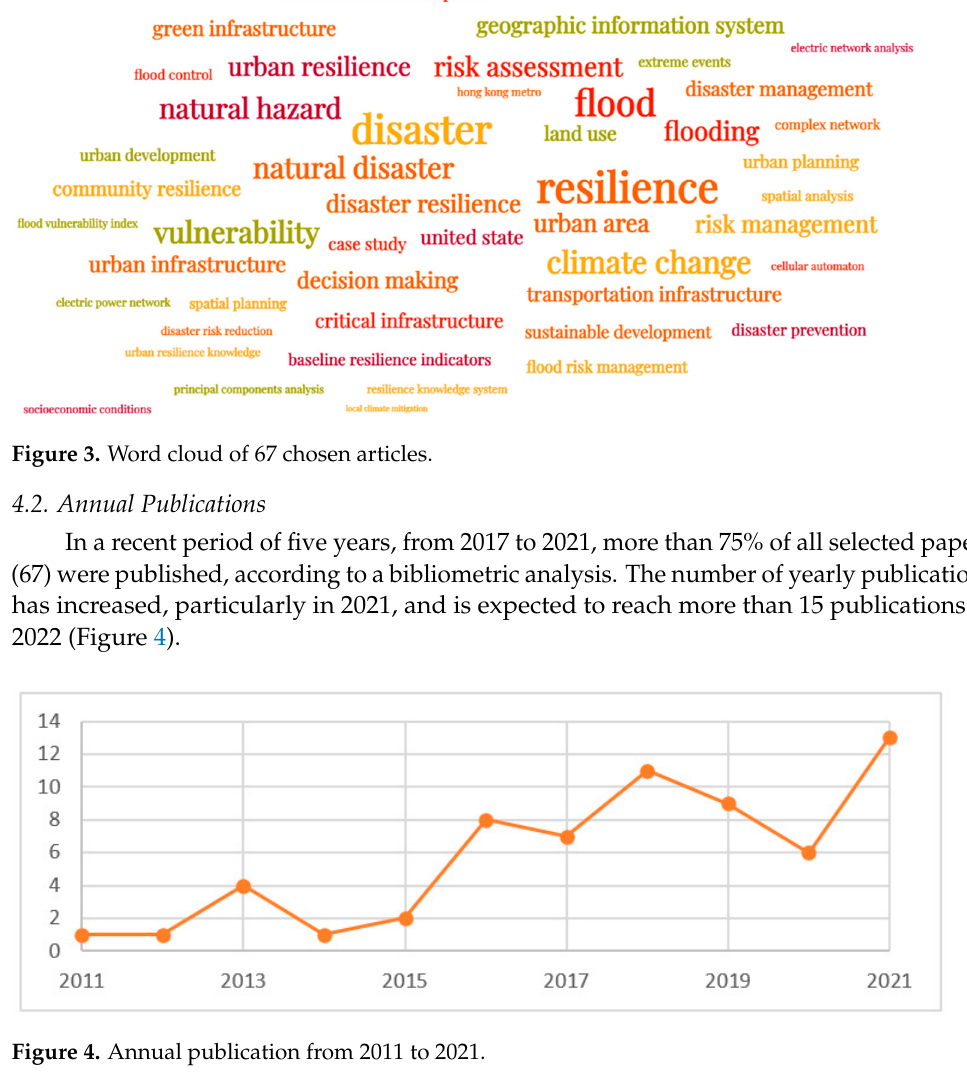
Figure 4. Annual publication from 2011 to 2021.